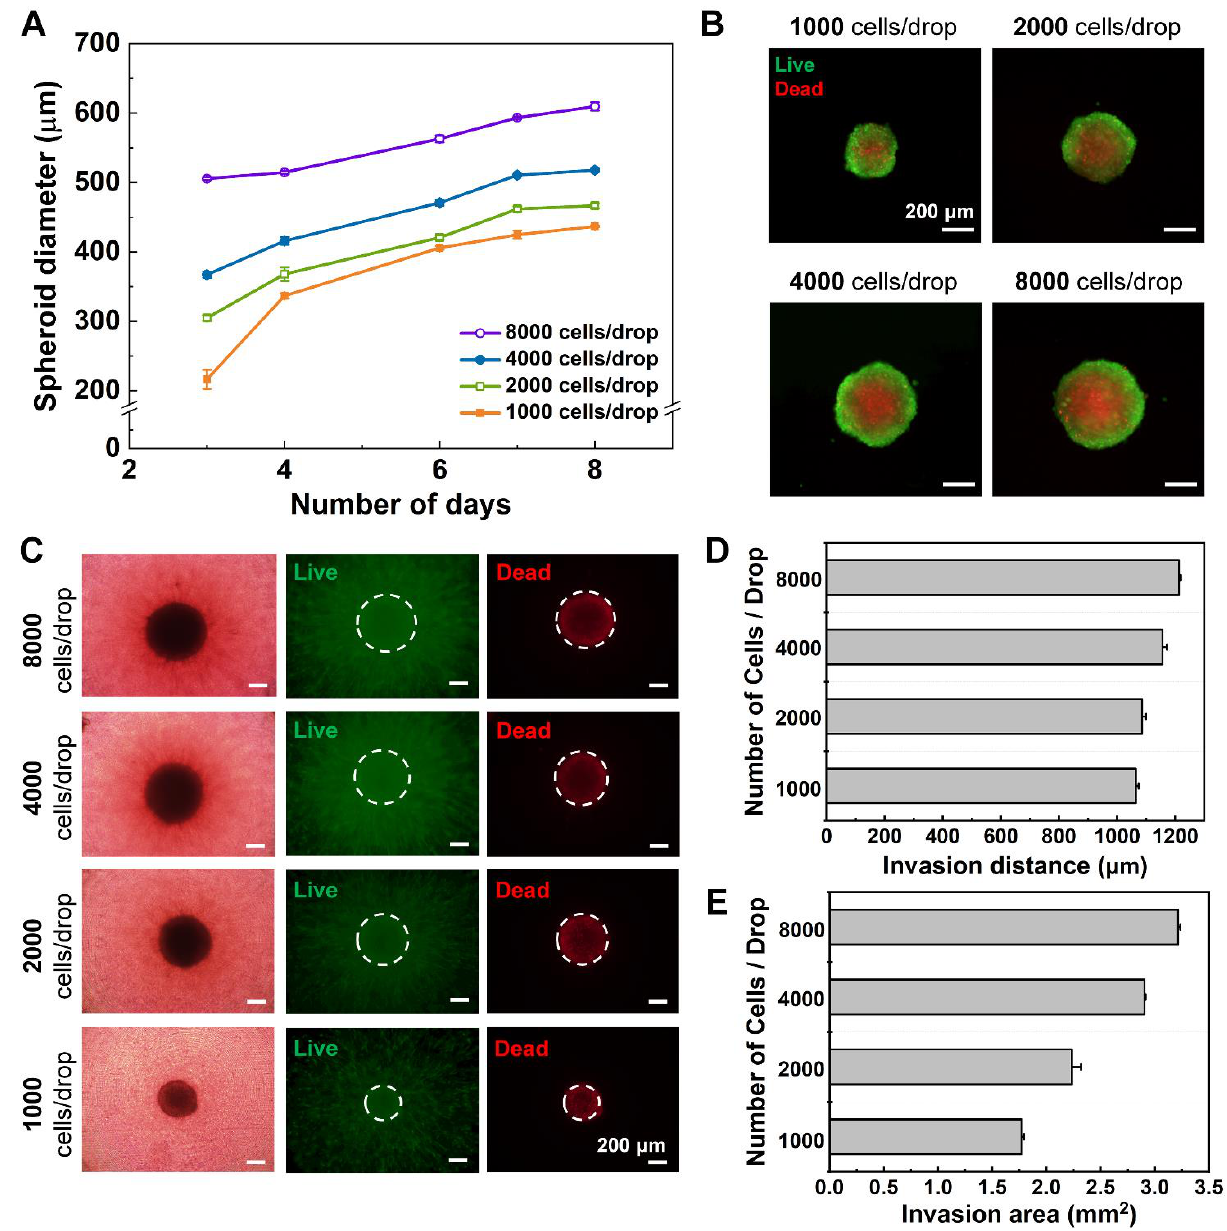
Figure 4. Growth and analysis of the invasive behavior of the glioblastoma multiforme spheroid using the improved DCST method. ( A ) A graph of the diameter of the spheroid of different initial seeding concentrations monitored for up to 8 days. ( B ) Fluorescent microscopic images of the spheroids of different seeding concentrations, stained with cell viability assay dyes to visualize the live (green) and dead (red) cells. ( C ) Microscopic images of the spheroid models embedded into collagen and cultured for 5 days. The spheroid models were stained with cell viability assay dyes to visualize the proliferated cells into the surrounding hydrogel. ( D ) A graph of the invasion distance of the spheroid – hydrogel models based on different initial seeding concentrations. ( E ) A graph of the invasion area of the spheroid – hydrogel models based on different initial seeding concentrations.